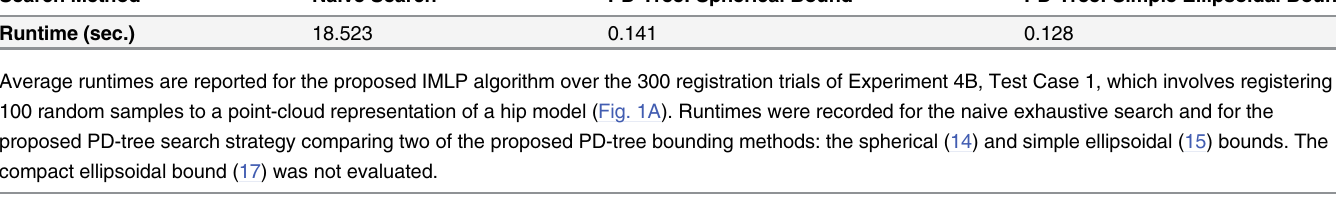
Experiment 8: Runtime Comparison of Methods for Computing the Most- Likely Matches